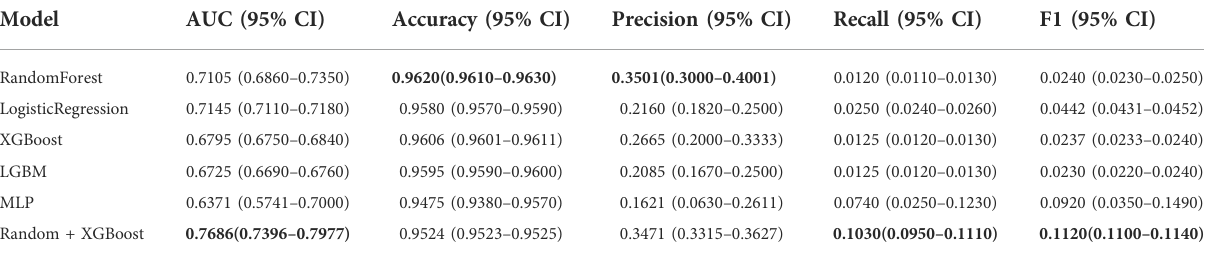
TABLE 2 Performance of classi fi cation models including all